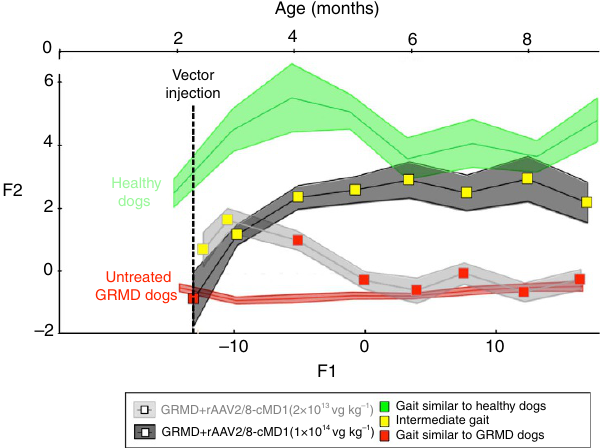
Figure 7 | Improved gait quality of GRMD dogs injected with rAAV2/8- Spc5.12-cMD1 by the IV route. The global gait quality was determined twice a month using Locometrix and analysed by a discriminant analysis of seven accelerometric variables. The curves represent the evolution of the mean gait index with 95% confident intervals (shaded areas) in healthy dogs ( n ¼ 9, including animals from retrospective cohorts, green curve), untreated GRMD dogs ( n ¼ 25, including animals from retrospective cohorts, red curve) and GRMD dogs injected intravenously with rAAV2/8- Spc5.12-cMD1 at 2 (cid:2) 10 13 vgkg (cid:3) 1 ( n ¼ 3, light grey curve) or 1 (cid:2) 10 14 vgkg (cid:3) 1 ( n ¼ 5, dark grey curve). F1 and F2 represent the two axes used to plot data during discriminant analysis. An additional axis corresponding to the age in months was also calculated and represented. The discriminant analysis (see details in the Methods section) allows a statistical evaluation to test the probability that the gait of the treated animals was similar ( P 4 0.95) to those of healthy dogs or of untreated GRMD dogs. The result of this statistical evaluation was represented as a colour code, using a green plot when the gait was found similar to those of healthy dogs, a red plot when similar to those of untreated GRMD dogs and yellow when the gait was considered as intermediate between healthy and untreated GRMD